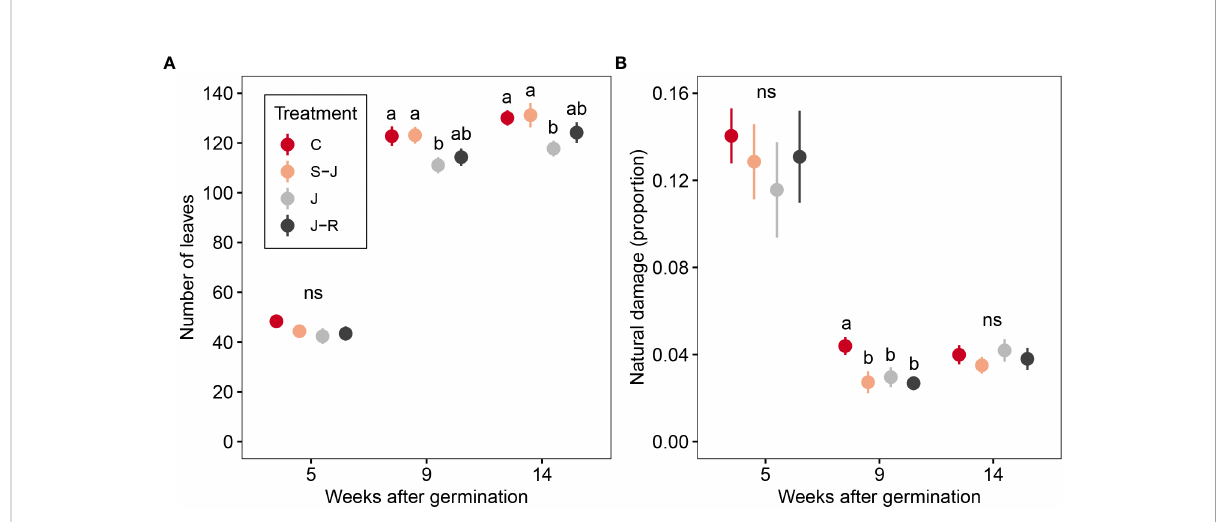
FIGURE 2 Effects of timing and frequency of damage on lima bean leaves. (A) number of leaves, (B) proportion of lea fl ets with uncontrolled natural herbivory. Treatment groups were: mechanically undamaged control plants (C); plants damaged at the seedling and juvenile stage (S-J), only at the juvenile stage or at the juvenile stage and reproductive stage (J-R). Different letters indicate signi fi cant differences among damage treatments within the same time point. ns indicate non-signi fi cant difference among damage